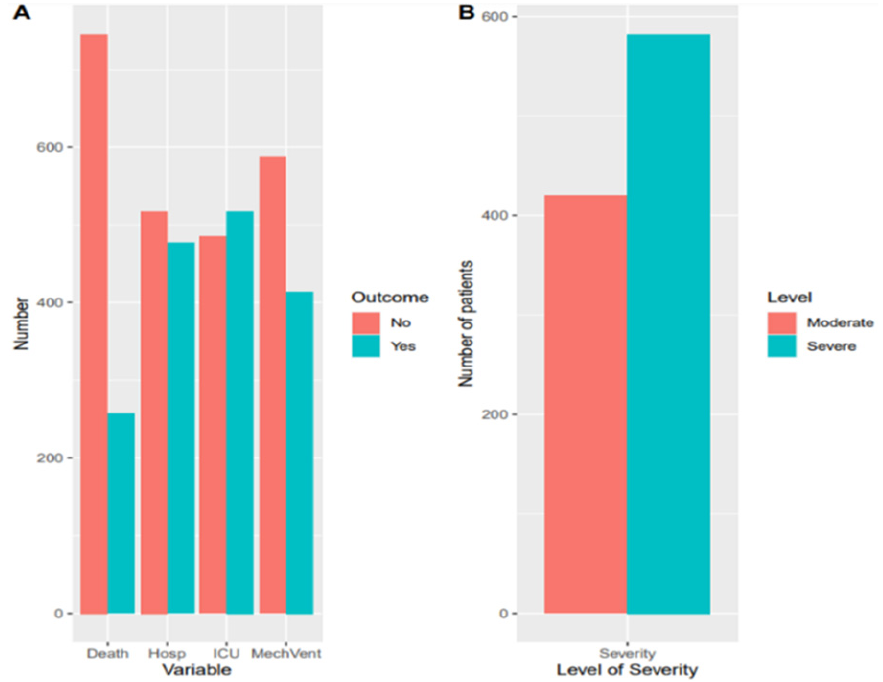
Figure 1. ( A ) COVID-19 outcomes. ( B ) Severity factors for moderate versus severe COVID-19 patients. Table 1. Descriptive characteristics of the COVID-19 hospitalized patients ( N = 1002).